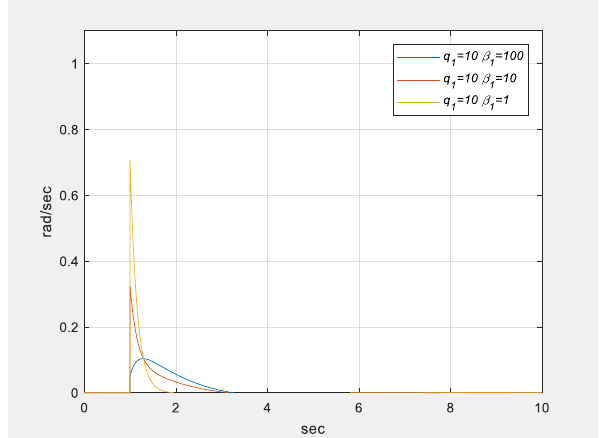
.  and the θ s and the  and the s s